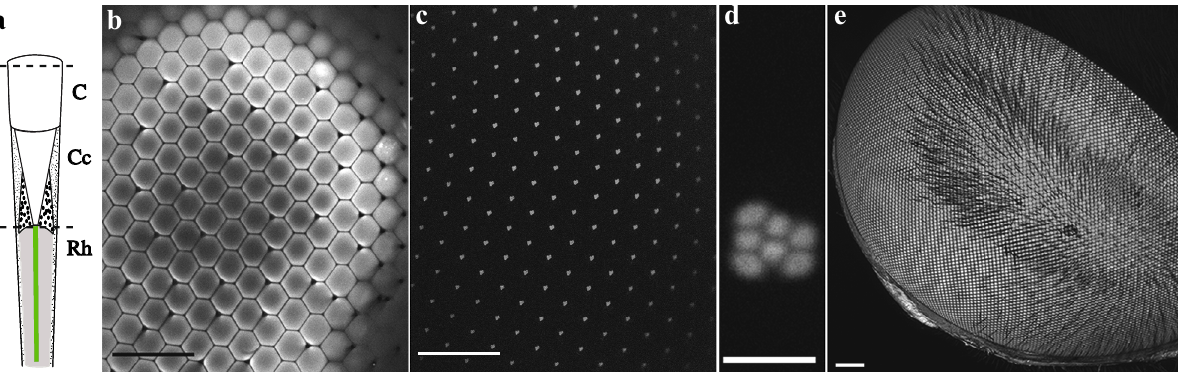
Figure 2. The fluorescence of the induced fluorescent pseudopupil originates from the rhabdomeres. (a) Diagram of a single ommatidium of a dipteran compound eye. Dotted lines denote the plane where optical cross sections of the eye in (b–d) were taken. From top to bottom: corneal facet (C), pseudocone (PC) and distal tip of the rhabdomeres (Rh). (b,c) Eristalis tenax compound eye after application of Lucifer Yellow and scanned with a confocal microscope, with a 63× glycerol objective. Scale bar 100 µm. The fluorescence observed at the surface of the eye (b) originates from the fluorescent rhabdomere tips as no other cells or parts of the photoreceptors are fluorescent when we focus below the cornea to the plane of the rhabdom tips (c) . (d) Magnified view from a single ommatidium, showing the distinctive trapezoidal shape formed by the distal tips of 7 adjacent rhabdomeres, typical of dipteran flies. Scale bar 5 µm. (e) Maximum intensity projection of a z-stack of the left eye of a female Eristalis tenax. When the dye (in this case Neurobiotin 488) had been